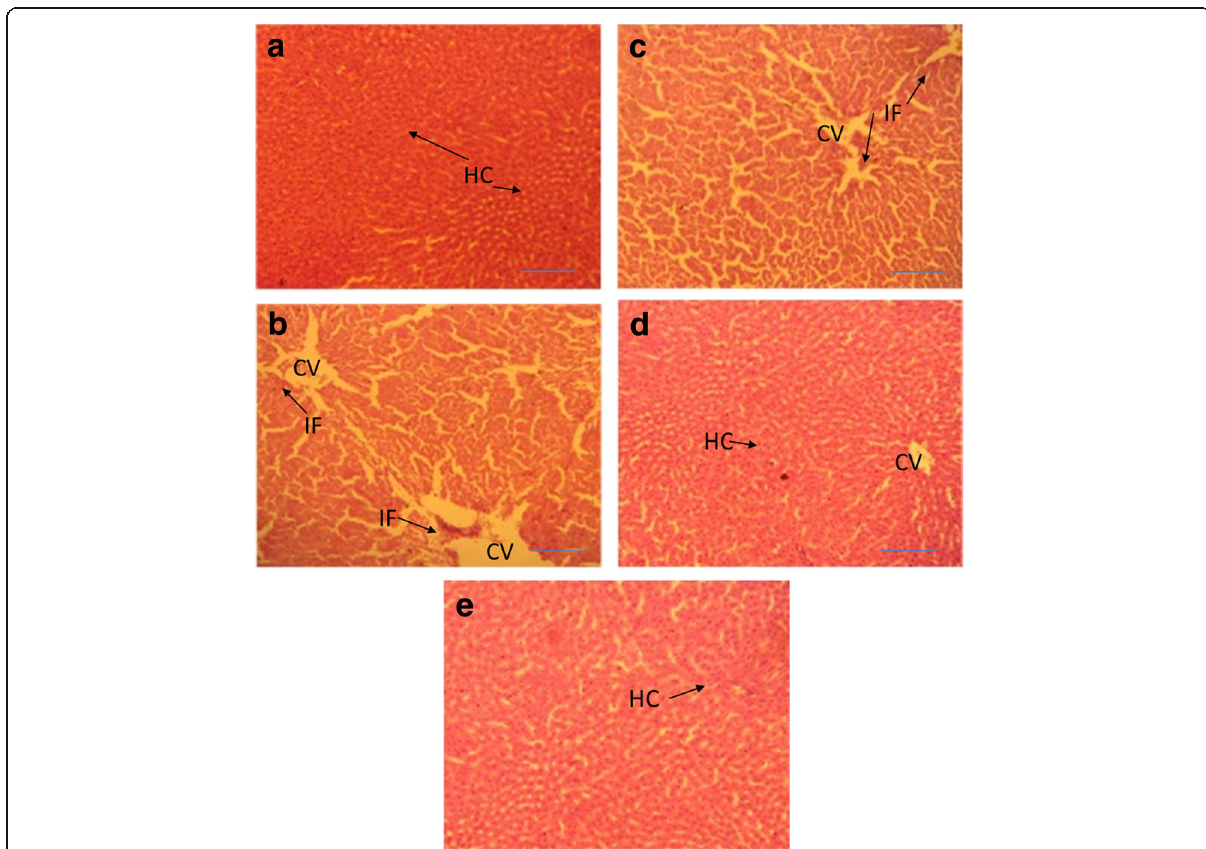
Fig. 4 Histopathological analysis of liver tissue of male Wistar rats administrated with CCl 4 and treated with AIS. a Control group shown normal lobular architecture with clear central vein (X-40). b CCl 4 administered group shown severe hepatocyte necrosis, fatty degeneration and vacuolation (X-40). c AIS treated group at 250 mg/kg shown mild improvement in chord arrangement but perinuclear vacuolation was visible (X- 40). d AIS treated group at 500 mg/kg shown normal cellular architecture with distinct hepatic cells sinusoidal spaces (X-40). e Silymarin (positive drug) treated group exhibited almost normal histology (X-40); Hepatocytes (HC), Central vein (CV) and Cellular inflammation